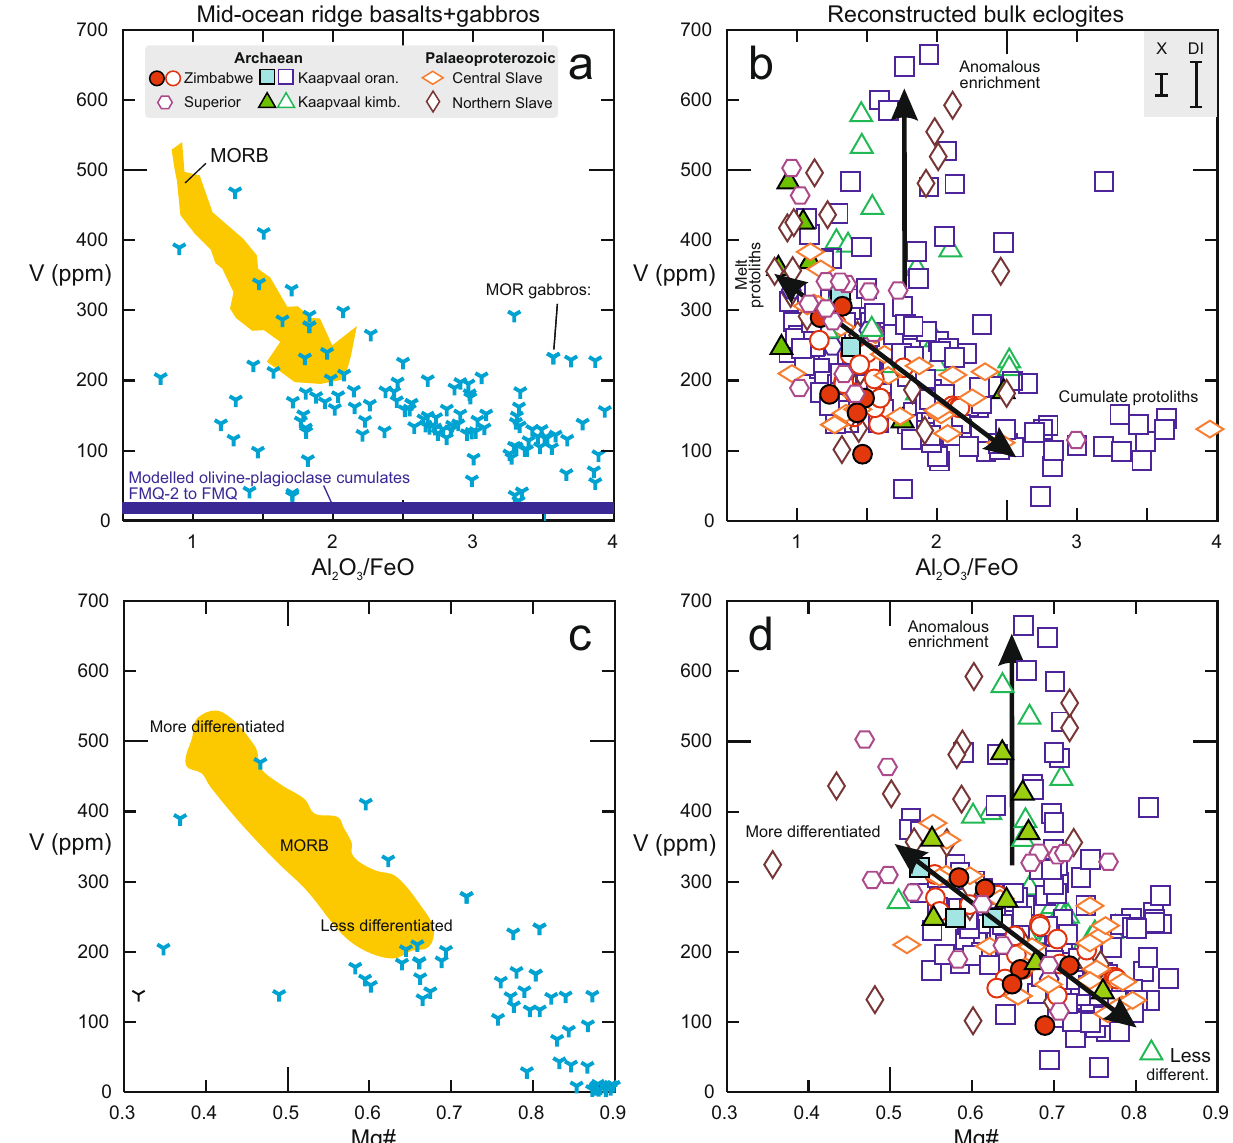
Fig. 3 Effects of low-pressure accumulation and differentiation on V abundances in eclogite protoliths. Vanadium abundances (ppm) in a mid-ocean ridge basalts (MORB; yellow fi eld 71 ) and MOR gabbros (blue tristars, Eu/Eu* > 1.05; from PetDB: www.earthchem.org/petdb), and b reconstructed bulk compositions of eclogite xenoliths (X) and inclusions in diamond (DI) as a function of Al 2 O 3 /FeO. Eclogites with suggested gabbroic cumulate vs. melt protoliths, and those showing inferred anomalous enrichment, are indicated in b . Shown in a is the range of compositions for olivine + plagioclase accumulating from a parental melt formed at Δ log ƒ O 2 (FMQ) − 2 to 0 (dark blue bar at bottom; modelling parameters and rationale in Methods; Supplementary Table 2). Vanadium abundances (ppm) in c MORB (yellow fi eld) and MOR gabbros (blue tristars), and d reconstructed bulk eclogite xenoliths and DI as a function of molar Mg# (Mg/(Mg + Fe total )), a proxy for the degree of differentiation during protolith formation. Eclogites with suggested less and more differentiated protoliths, and those showing inferred anomalous enrichment, are indicated in d . Error bars for reconstructed bulk rocks in b show average propagated 1 σ uncertainties on V abundances of 29 ppm for xenoliths and 69 ppm for DI (Methods). Data sources in Supplementary Data